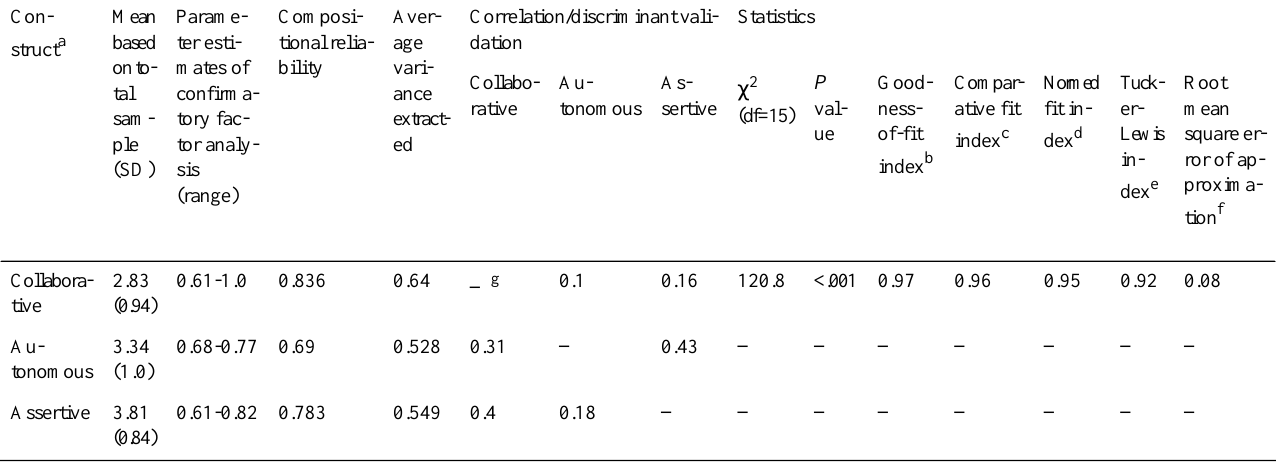
Table 3. Descriptive statistics and convergent and discriminant validity